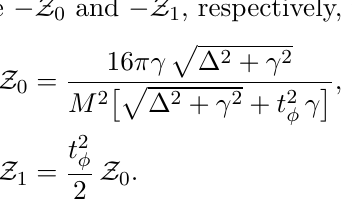
and (cid:0) i Z 1 = 2 , respectively, where 0 1